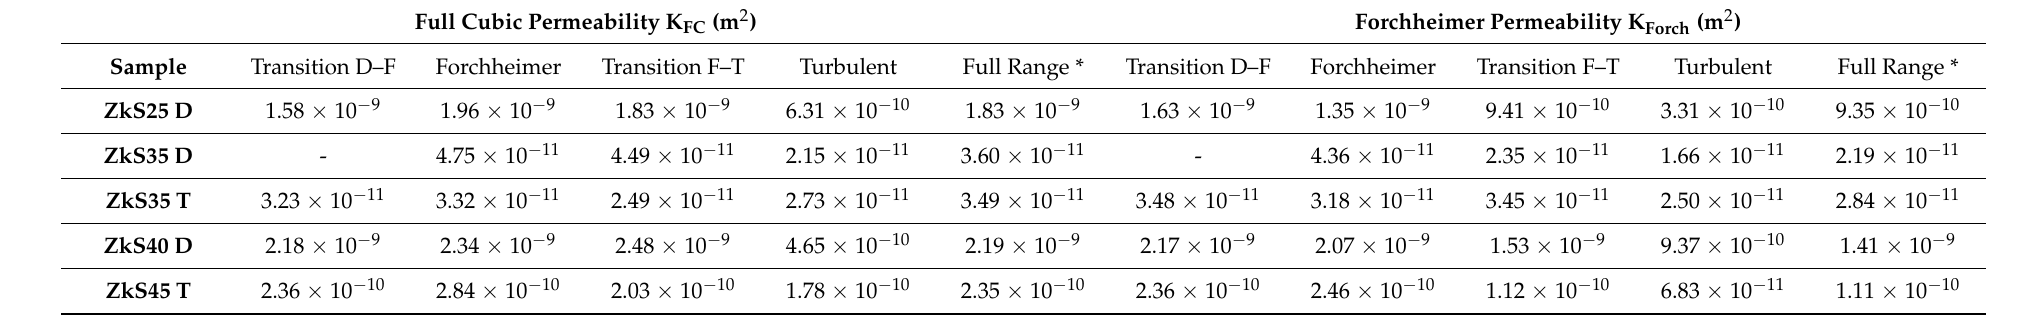
Table 3. The permeability fitted by the full cubic law and Forchheimer equation for all flow regimes of air flow through ESR foams.